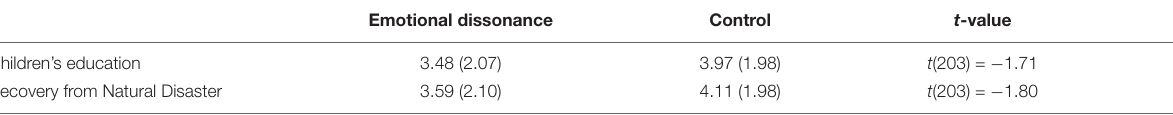
TABLE 1 | Sympathy for others’ feeling.